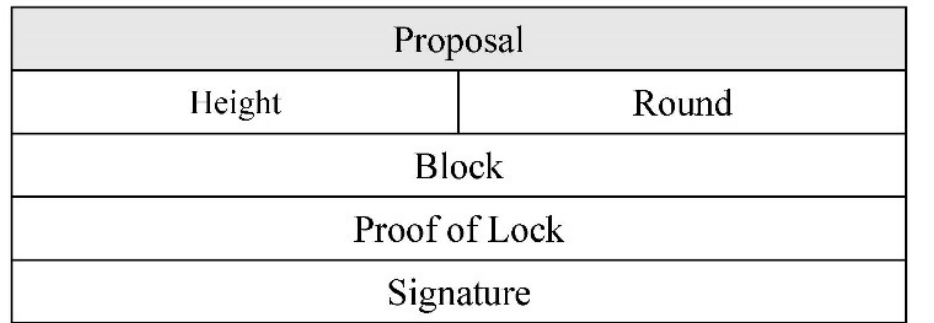
Figure 3. Vote structure.